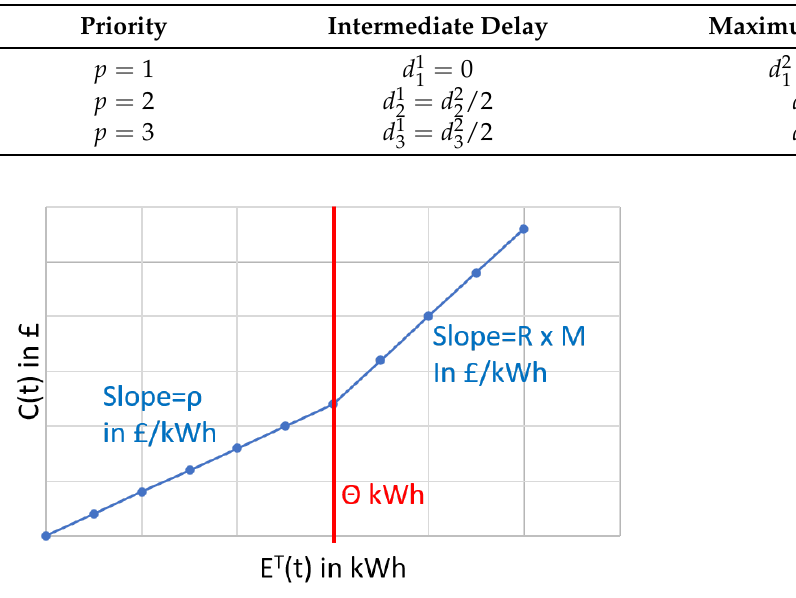
Table 2. Appliance priorities and related delays.